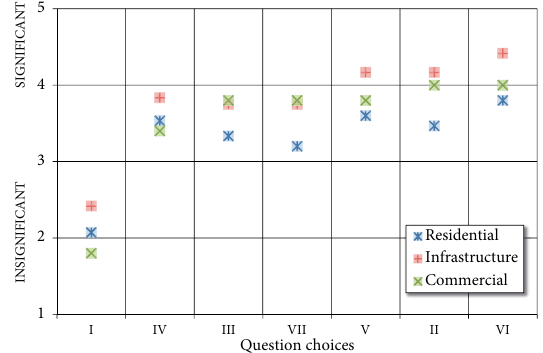
Fig. 7. Significance of internal business factors based on main activity